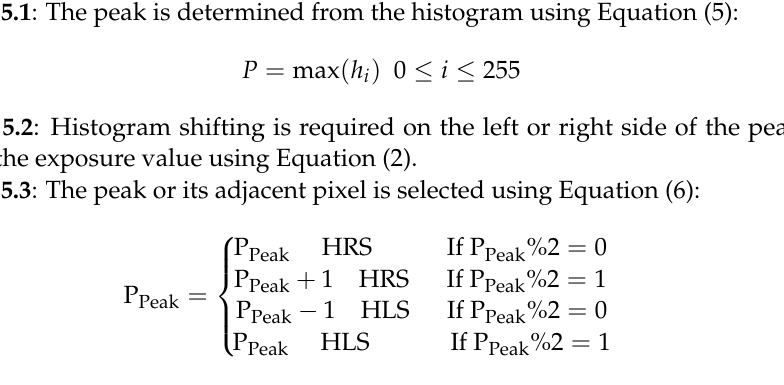
Figure 10. The direction of histogram adjustment in a